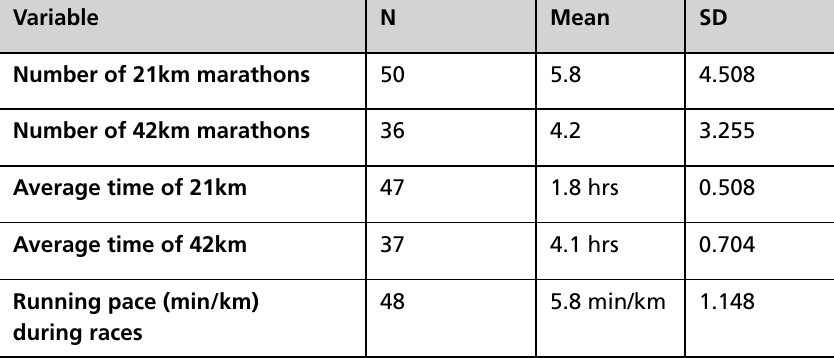
table 2: Marathon participation (n=50). Mean and